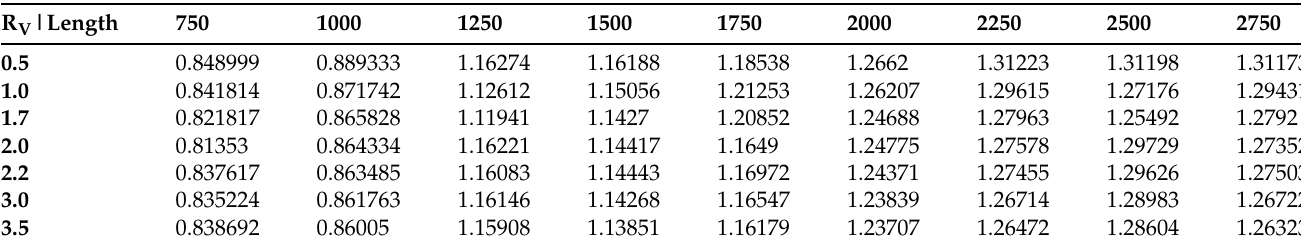
Table A12. Execution times in milliseconds on GPU with cable structure for 20,000 time-steps (1.0 s); R V on the Left and number of cells (length) on the Top